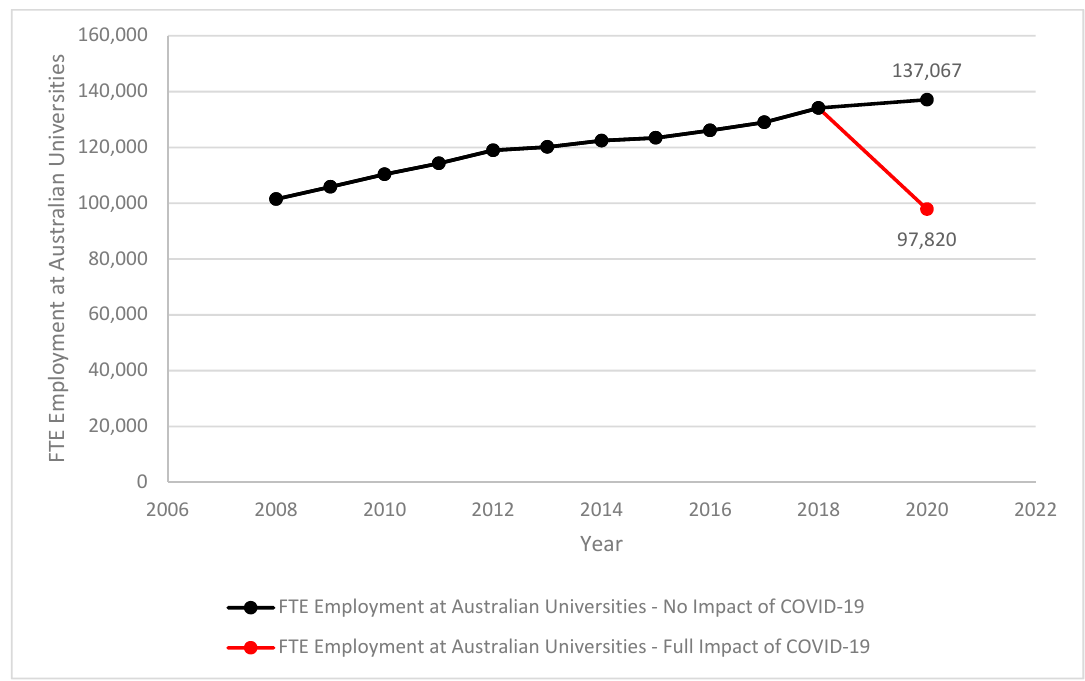
Figure 7. Impact of COVID-19 on FTE Employment at Australian Universities.